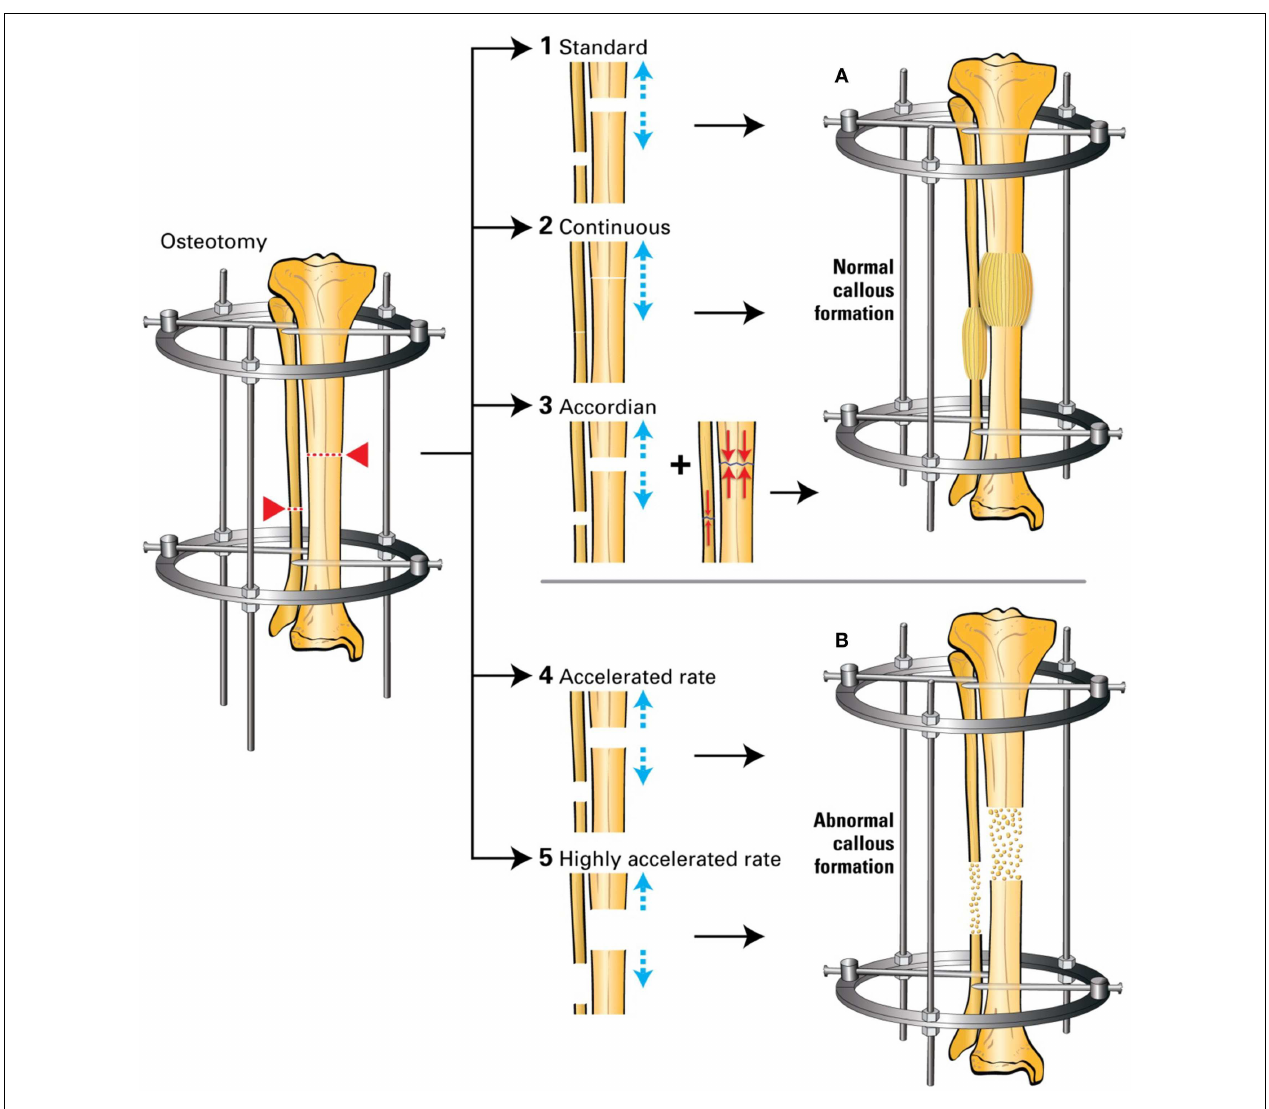
FIGURE 5 | (1) Standard DO: 0.25mm/6h to achieve 1mm/24h; (2) continuous DO: 0.02mm/24min to achieve 1mm/24h; (3) accordion maneuver: addition of compression to the standard distraction;